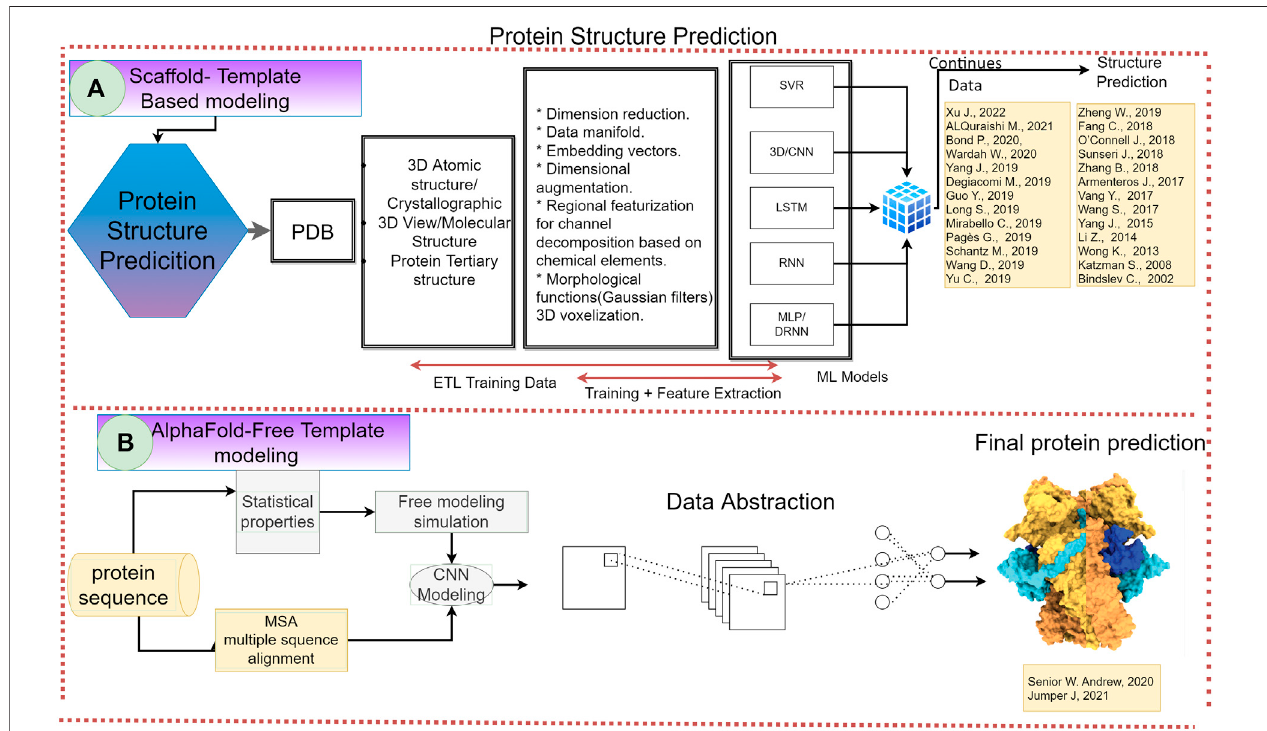
FIGURE6| Representationofthespeci fi ccaseforproteinstructurepredictioninthesupervisedlearningframework.Revealingthemostcommon fl owfollowedby the studies analyzed. From extraction, training data, feature extraction procedures and data continuity. Including the PDB database, the most common supervised algorithms, SVM, SVR,